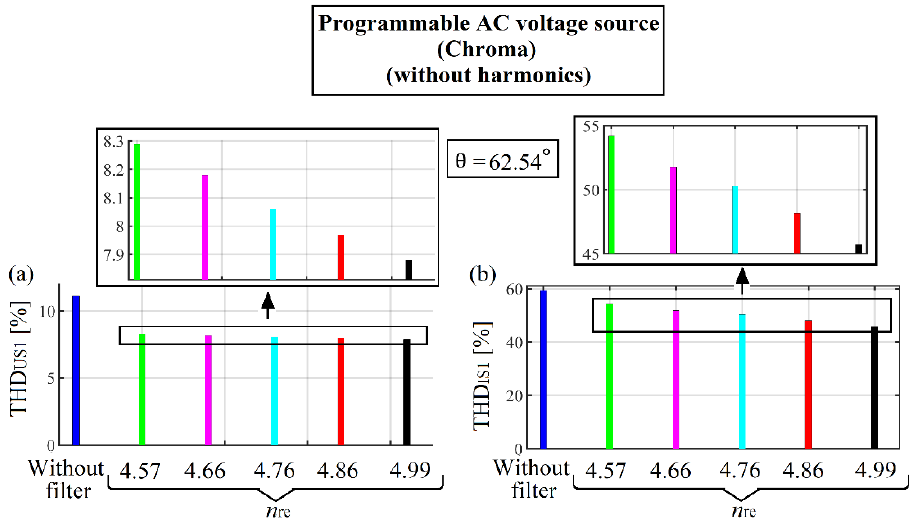
Figure 63. PCC voltage ( a ) and current ( b ) THD.